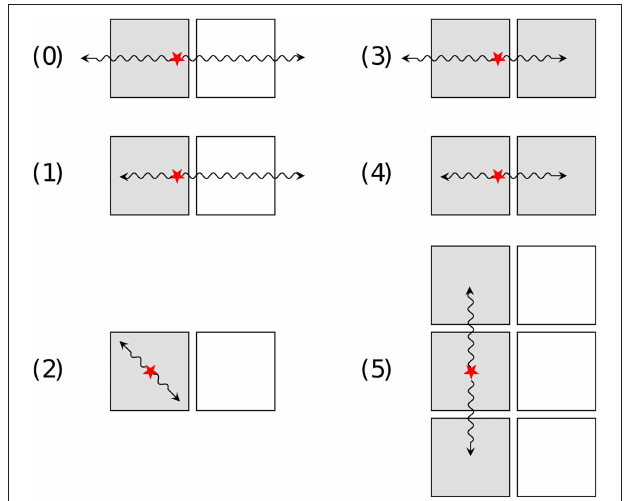
FIGURE 8 | Signatures of the 0 νβ + EC decay of 120 Te in CUORE-0. The red stars indicated the energy depositions by the β + , while the arrows represent the resulting annihilation 511-keV γ rays. The shaded squares show the crystals which see an energy deposition. Figure from Alduino et al. [100], with permission from the American Physical Society.